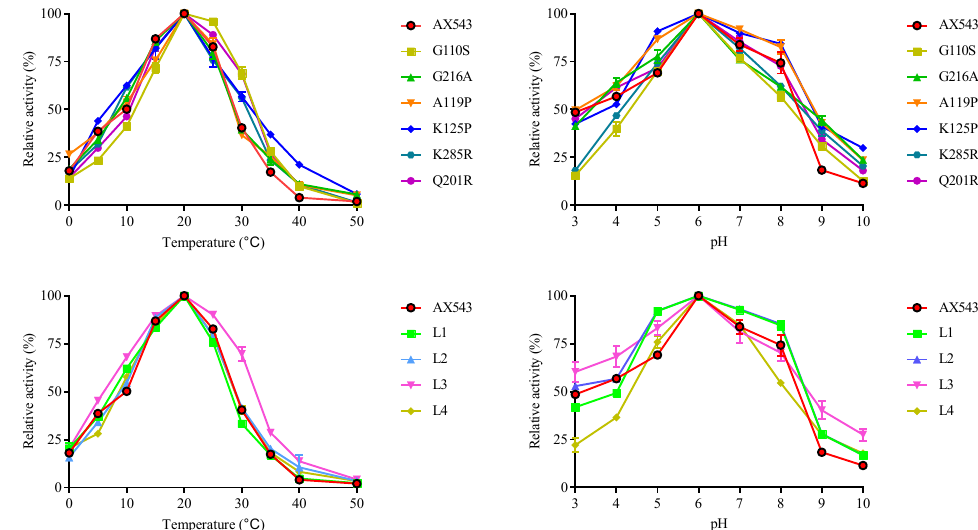
Figure 2. The effects of temperature and pH on the wild type and site-directed variants.